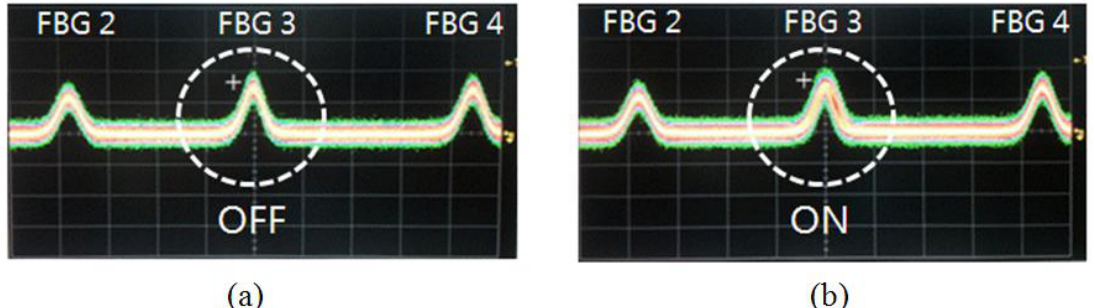
Figure 3. Photograph of the oscilloscope trace ( a ) without dynamic strain and ( b ) with dynamic strain.